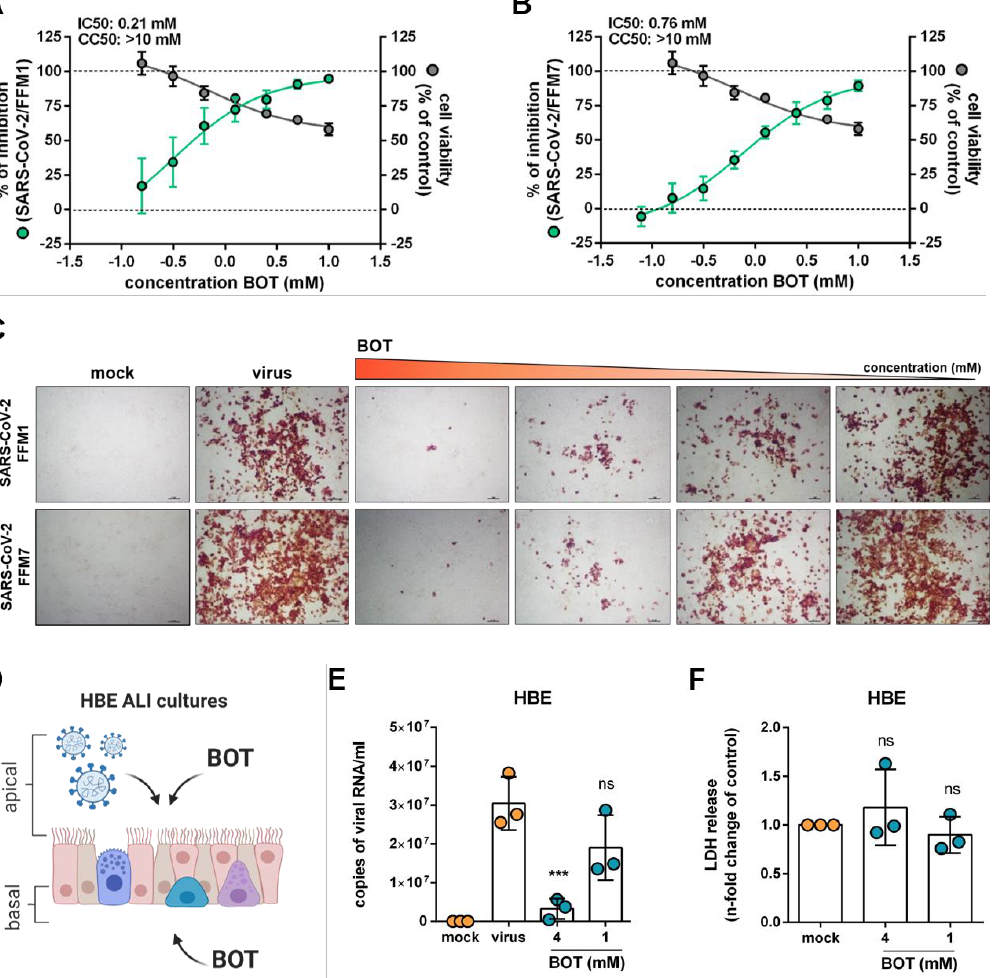
Figure 3. Targeting the pentose phosphate pathway (PPP) in SARS-CoV-2-infected cells. ( A , B ) Effects of the TKT inhibitor benfooxythiamine (BOT) on virus replication and cell viability in SARS-CoV-2 strain FFM1 and FFM7 (MOI 0.01)-infected Caco2 cells 24 h post infection. Caco-2 cells were pre-treated with different concentrations of BOT for 24 h. Percentage of viral inhibition was evaluated by spike (S) protein staining, and cell viability was measured by MTT assay. The IC50 and CC50 values were determined using the curve regression function of GraphPad Prism 8. Both plots represent mean ± SD of the three independent experiments. ( C ) Representative images illustrating SARS-CoV-2 S protein levels in SARS-CoV-2/FFM1 and SARS-CoV-2/FFM7 (MOI 0.01) infected Caco-2 cells treated with BOT 24h post infection. ( D ) BOT treatment strategy of air-liquid interface (ALI) cultures of primary human bronchial epithelial (HBE) cells infected with SARS-CoV-2/FFM7 (MOI 1). ( E ) Quantification of viral genomic RNA copy numbers in apical washes five days post infection. Bars represent mean ± SD of the three biological replicates. ( F ) Cytotoxicity assay measuring LDH levels in apical washes of BOT-treated HBE ALI cultures in comparison to untreated control. Bars display mean ± SD of the three biological replicates. *** p ≤